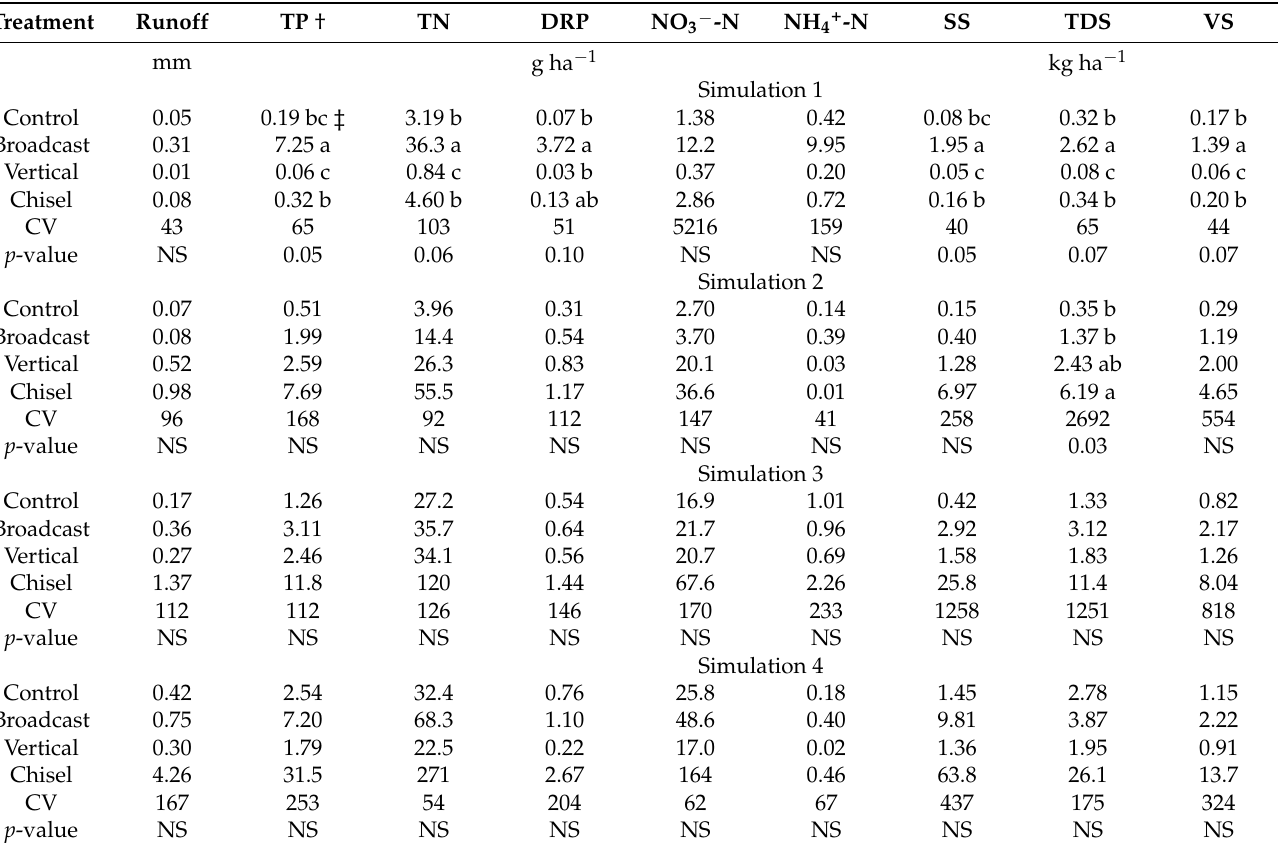
Table 2. Overland flow and nutrient loads for each